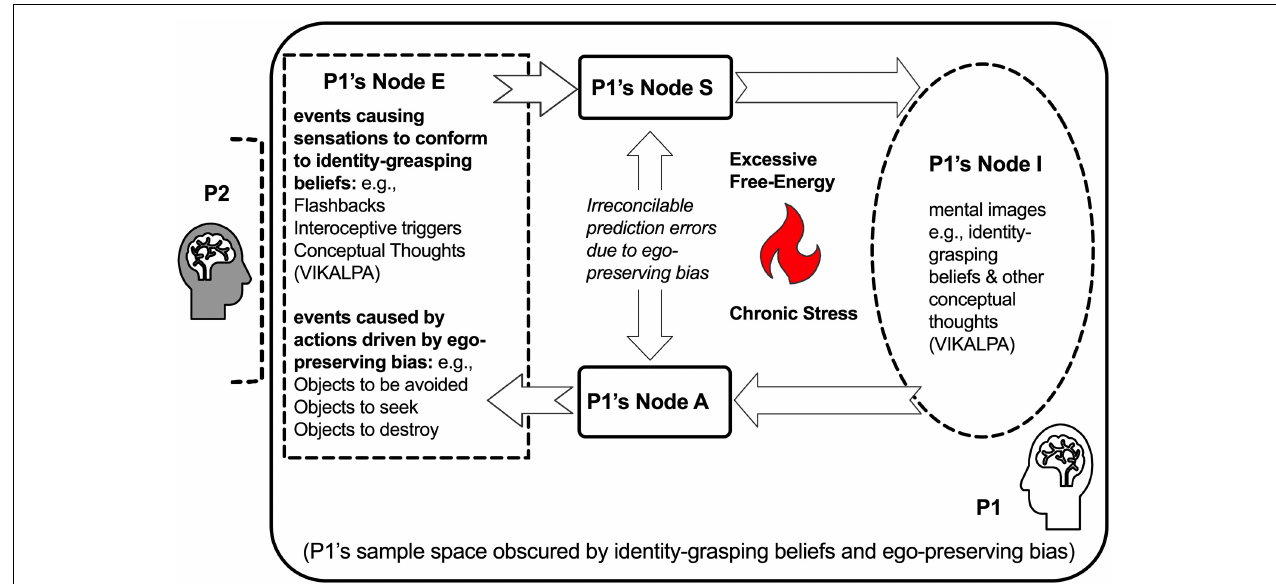
FIGURE 2 | Bayesian Engine in a state that identity-grasping beliefs and ego-preserving bias obscure its sampling space. When identity-grasping beliefs and other conceptual thoughts (VIKALPA) “hijack” a person P1’s Node I, these conceptual thoughts explain away prediction errors without attuning to another person P2. The reactions to the events from Node E pre-occupy P1’s Nodes S, A, and I at the expense of actual attunement to P2’s Bayesian Engine, manifesting as an ego-preserving bias. Outwardly, the identity-grasping beliefs in P1’s Node I drive P1’s Node A (escape, aggression, or acquisition) to avoid fear-provoking objects and/or seek distracting or addictive objects with negative reinforcement; Inwardly, the sampling of the events is biased toward covert cues, e.g., trauma-related flashbacks, interoceptive triggers, and conceptual thoughts (VIKALPA) that cause fear, anger, or obsession in P1’s Node S to re-confirm the conceptual thoughts (VIKALPA) in P1’s Node I. In such an obscured state, P1 fails to infer and “see” the other person in the relationship, denoted by the dashed bracket in front of P2. The obscuration of P1’s Bayesian Engine is denoted by the other person P2 who is excluded from P1’s sample space. Due to the conflicts that are not constructively reduced by the obscured Bayesian Engine, excessive free energy ensues and results in chronic